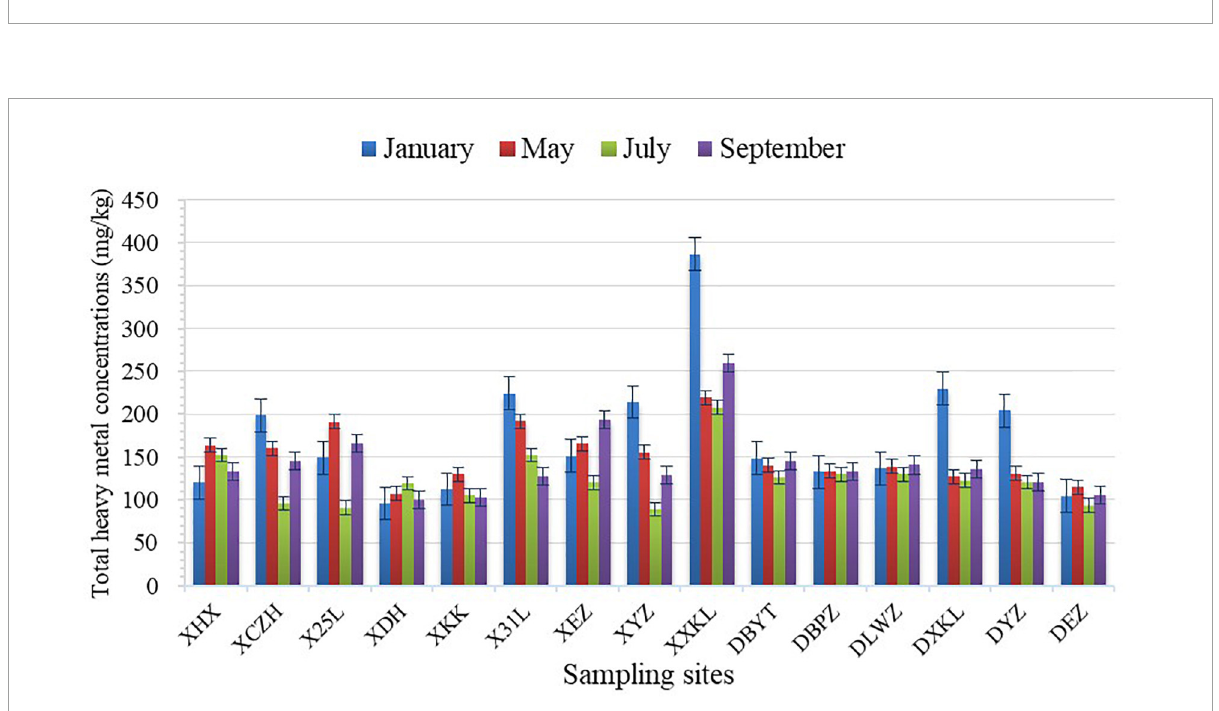
FIGURE4 Total heavy metal concentrations in all sampling sites in January, May, July, and